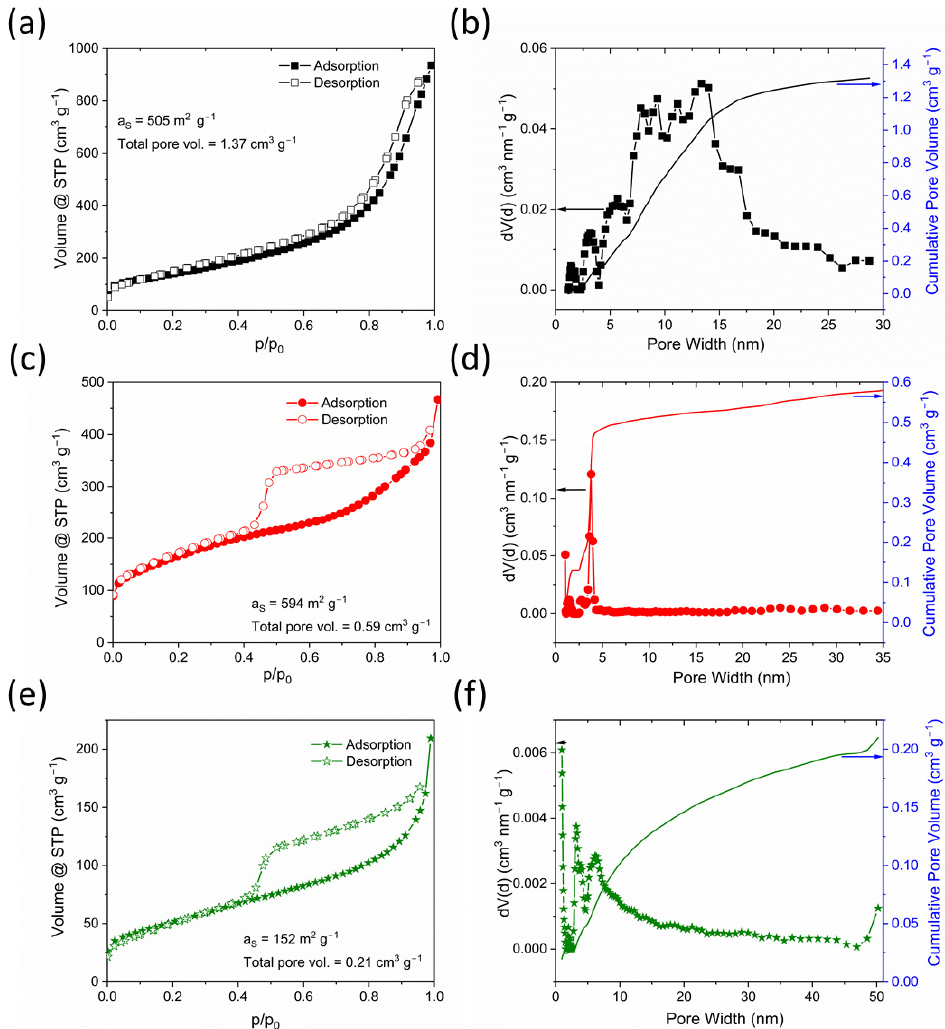
Figure 3. ( a ) N 2 physisorption isotherms and corresponding QSDFT pore volume and pore size distributions (PSD) of ( a , b ) OLC-N, ( c , d ) OLC-B, and ( e , f ) OLC-M.